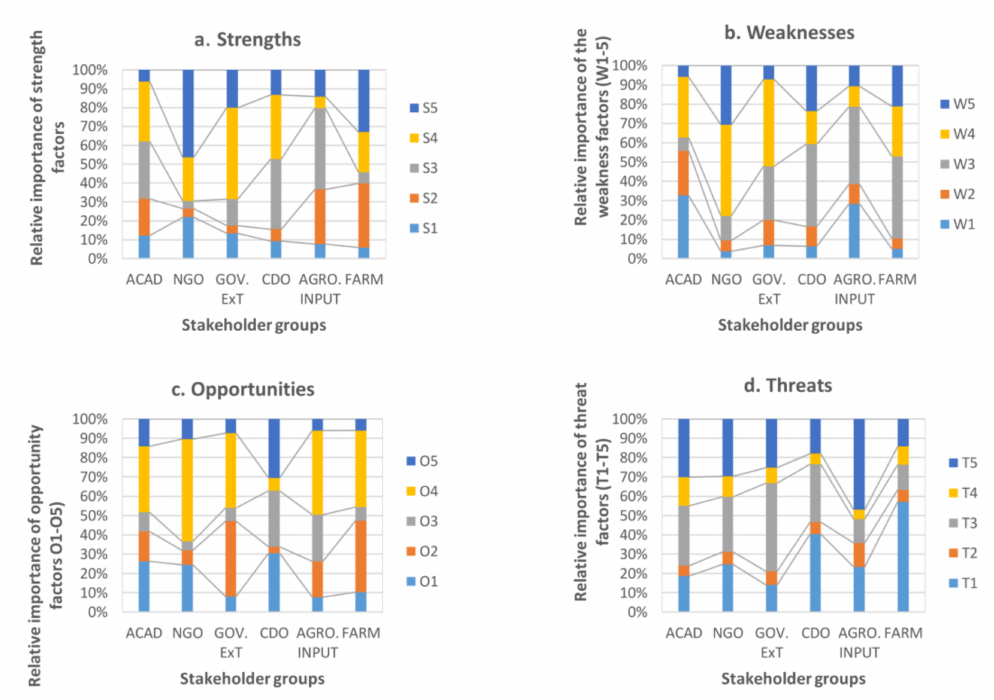
Figure 2. Perceptions of stakeholders on importance of ( a ) strengths; ( b ) weaknesses; ( c ) opportunities and ( d ) threats of agronomic iodine biofortification. ACAD: academic group; NGO, Non-Governmental Organization; GOV.EXT: government extension group; CDO: Community Development